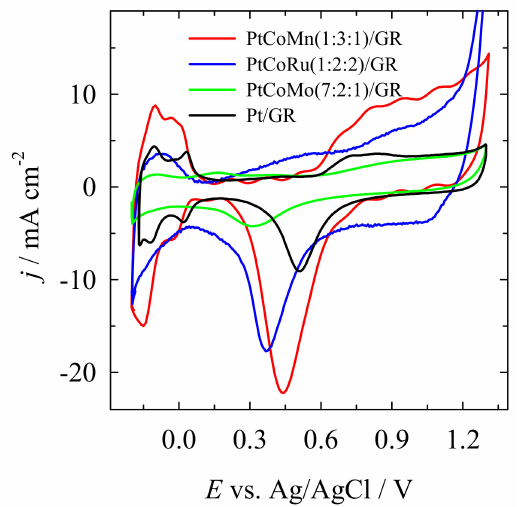
Figure 4. CVs of the PtCoMn(1:3:1)/GR, PtCoRu(1:2:2)/GR, PtCoMo(7:2:1)/GR, and Pt/GR catalysts recorded in a 0.5 M H 2 SO 4 solution at a sweep rate of 50 mV s -1